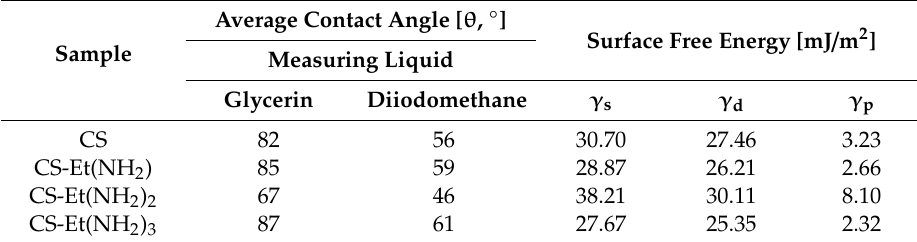
Table 2. Contact angle measurement results for modified